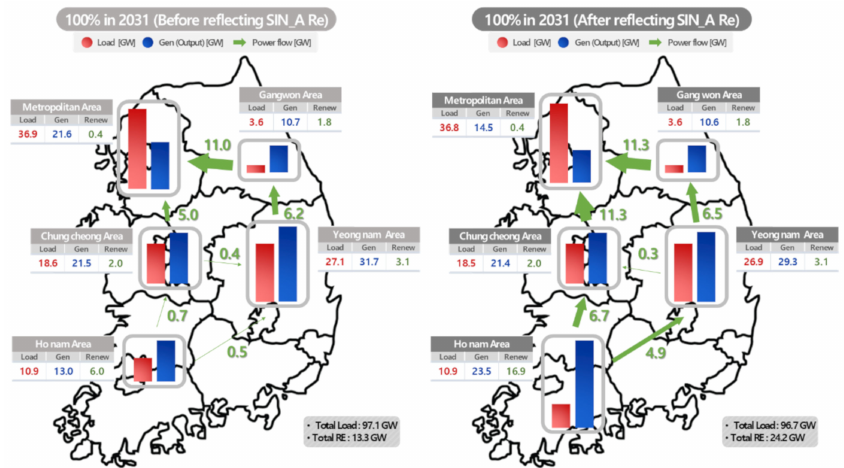
Figure8. Powerflowsystemdiagrambeforeandafterdispatchduetorenewableenergyinterconnection.